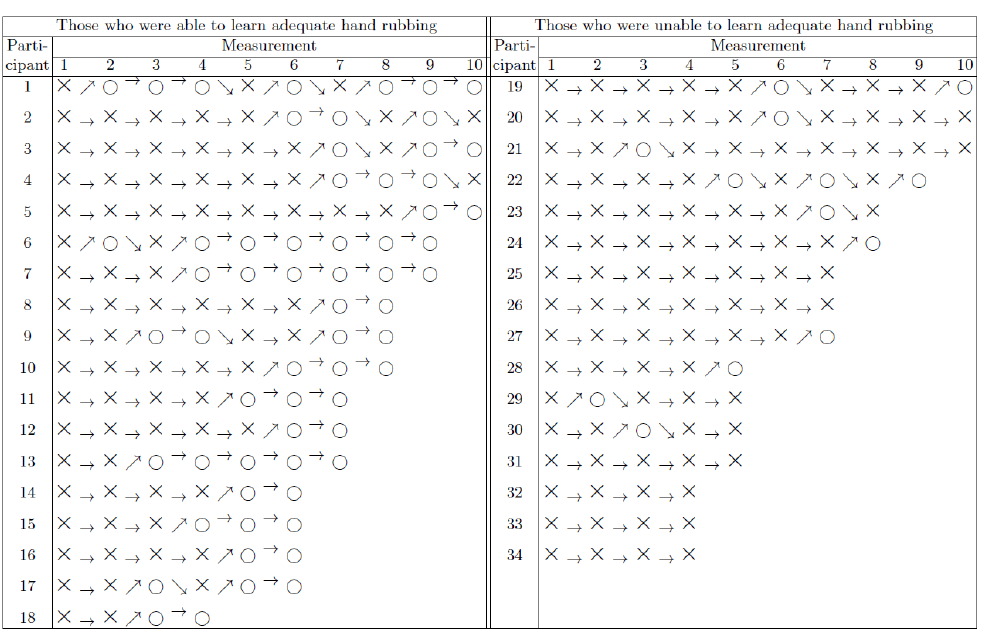
Figure 6. Overall statistics of consecutive measurements using 1.5 mL ABHR. Participants were separated into two groups: we defined the criterion for being able to learn adequate hand rubbing technique as being able to produce perfect coverage at two consecutive measurements. According to Figure 4, 53% (CI 95%: 37 – 69%) of the par- ticipants could comply with this requirement. The two groups of participants shown in Figure 4, namely those who were able to produce perfect coverage at least two consecutive times and those who were not, have been compared with respect to the age, hand projec- tion area, and the difference in coverage of the participant. Table 2 presents the recorded numbers at the NICU regarding ABHR consumption and HAI ratio (for the period public data was made available). It has been recorded that the ABHR consumption stood out of the year of the study, rising to 157% of the 4 -year average, while there was a drop down in the consecutive years. In the meanwhile, HAI numbers could not be correlated to the handrub use.